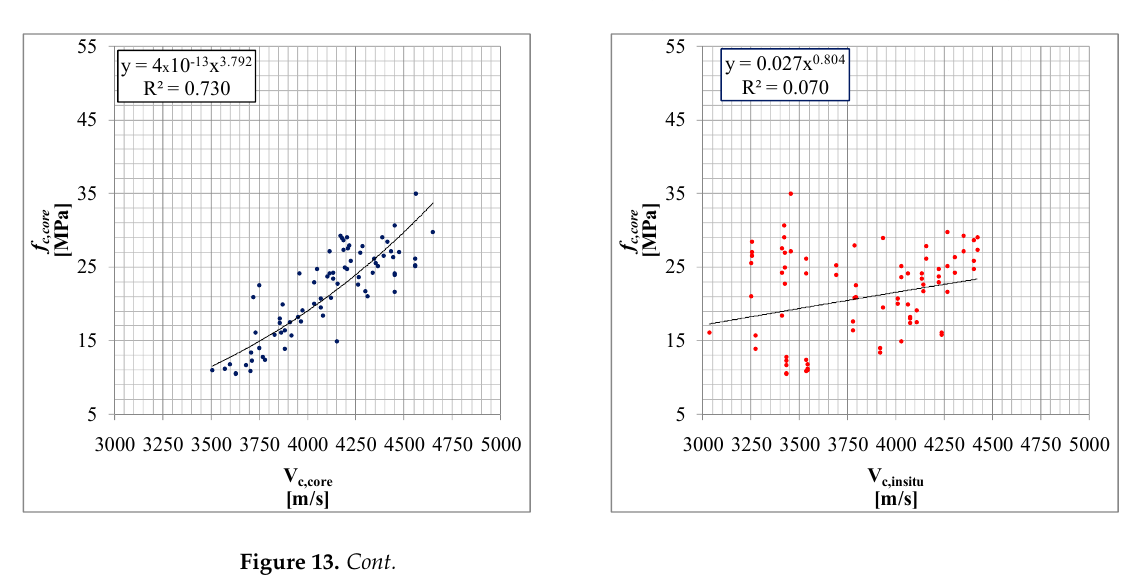
Figure 12. Comparisonof direct ultrasonic velocity samples vs. compressive concrete strength ( a ) and in situ ultrasonic velocity vs. compressive concrete strength ( b ).